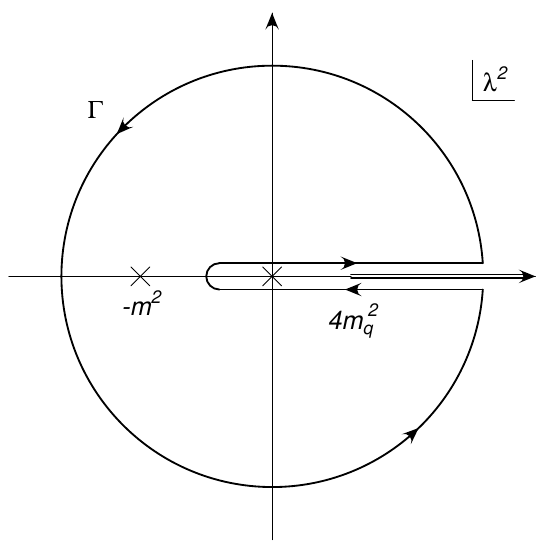
After having taken the limit m and